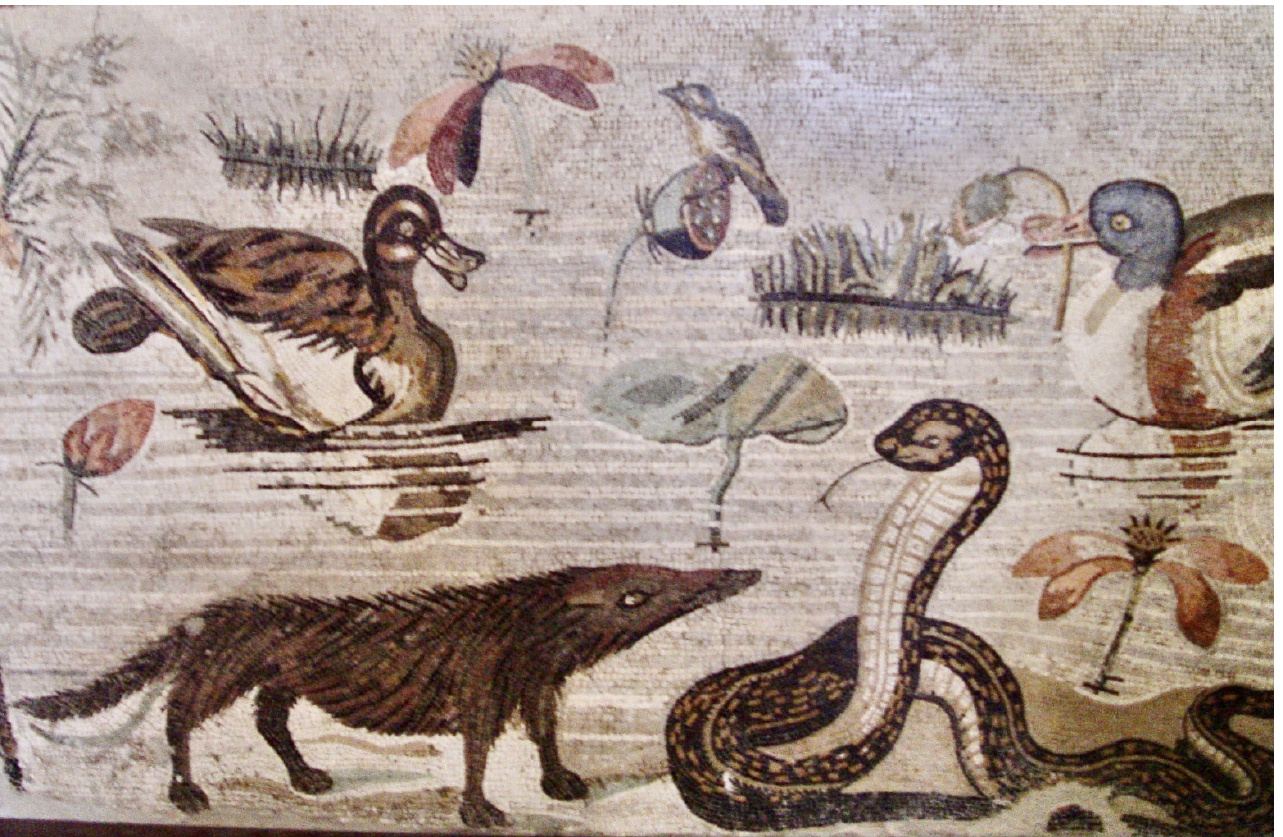
Figure 6. A vignette of the confrontation between an ichneumon and a cobra from the framing element of the mosaic of Alexander the Great, Naples, National Archaeological Museum, 10020.